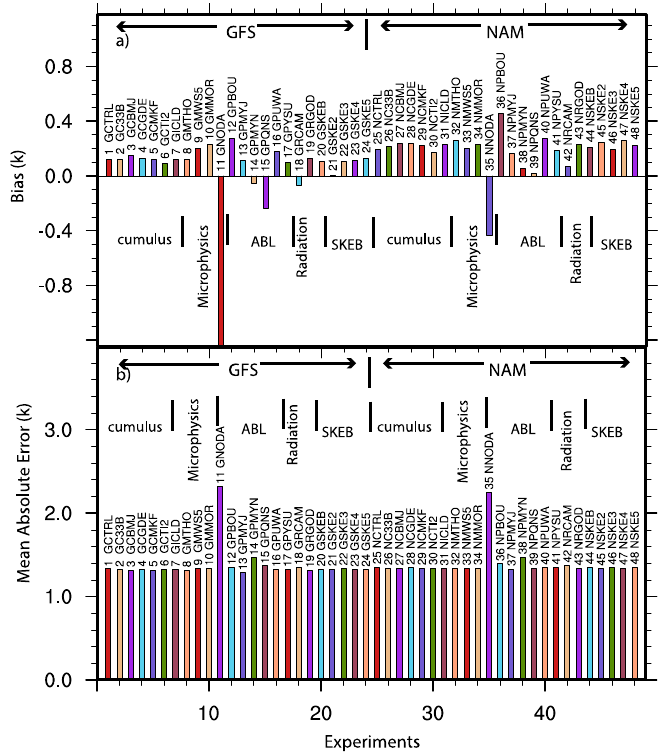
Figure 11. Averages on Domain 3 of ( a ) bias and ( b ) MAE in T2 from analyses during the one-week study period in July.